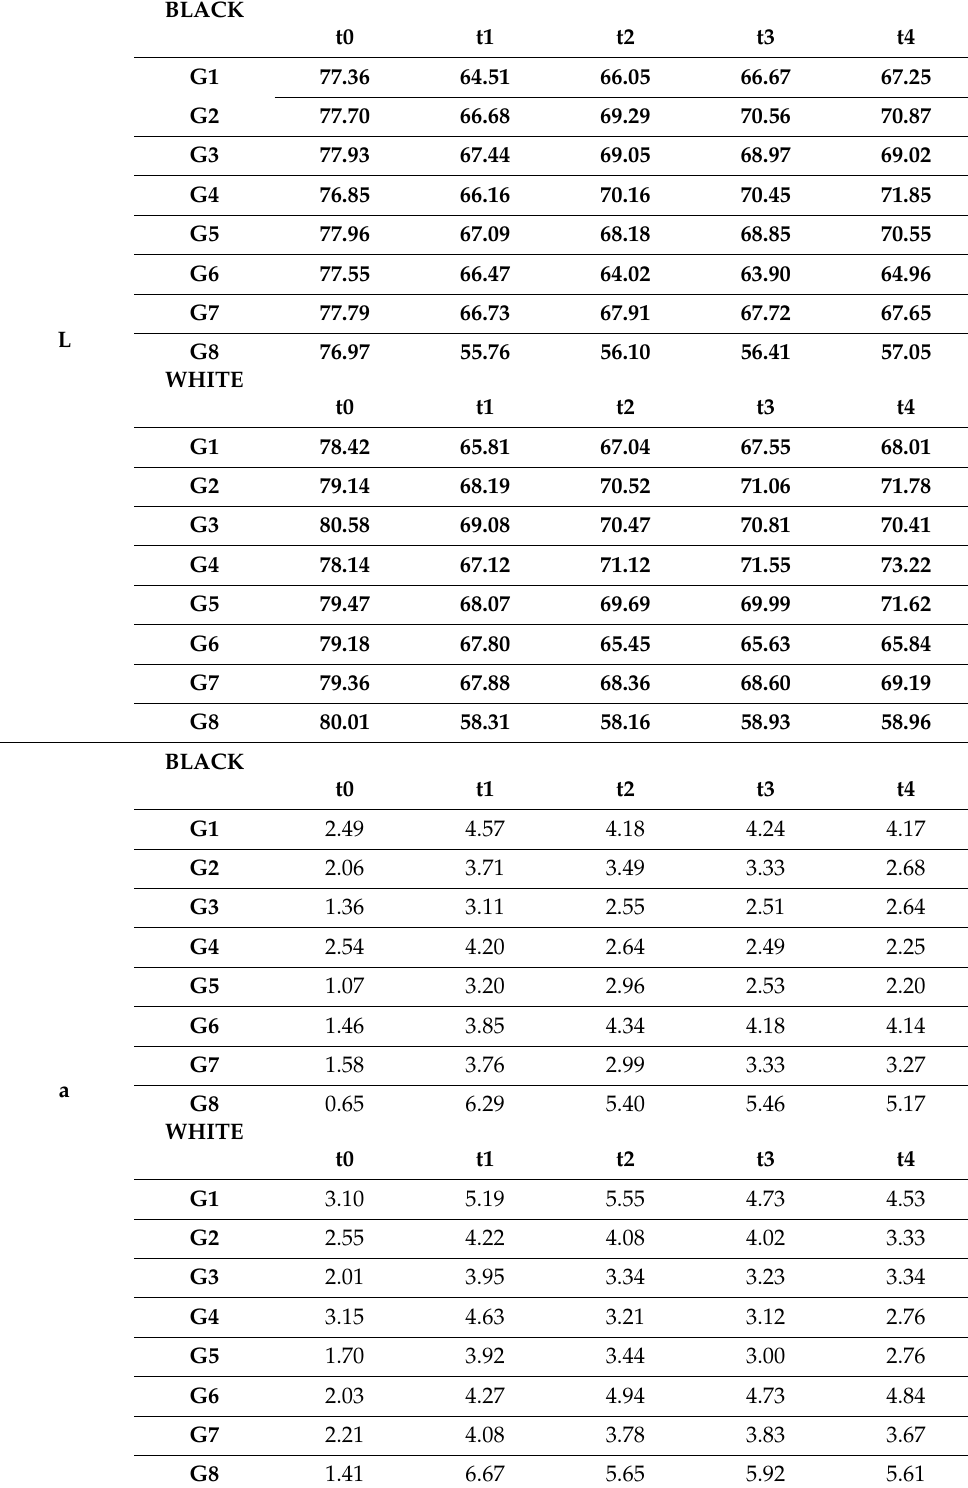
Table 9. L*a*b* change over time for every bleaching agent over a black and a white